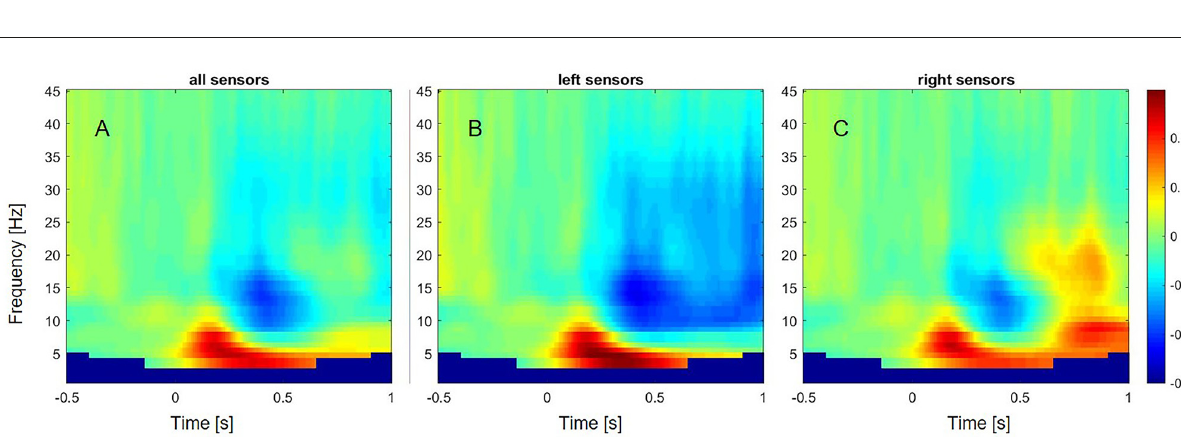
Highest laterality was seen within the frontal language area (mean LI = 0.91, range 0.28–1.0), somewhat lower LIs were observed for WA with a mean LI of 0.77 (range